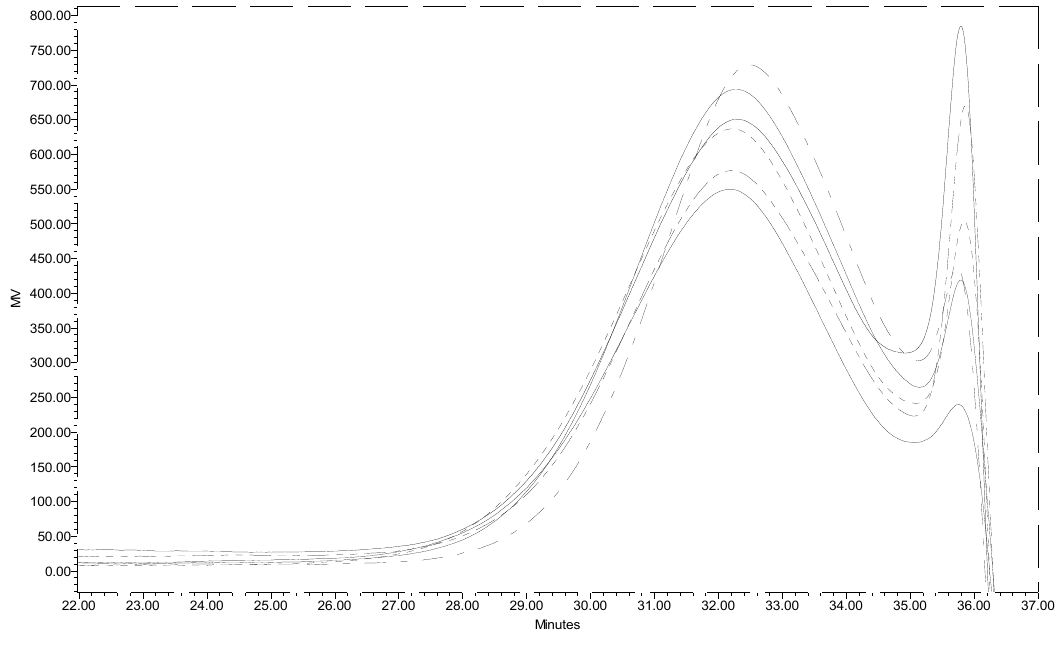
Figure 1. Segments of the GPC profiles of six low molecular weight chitin